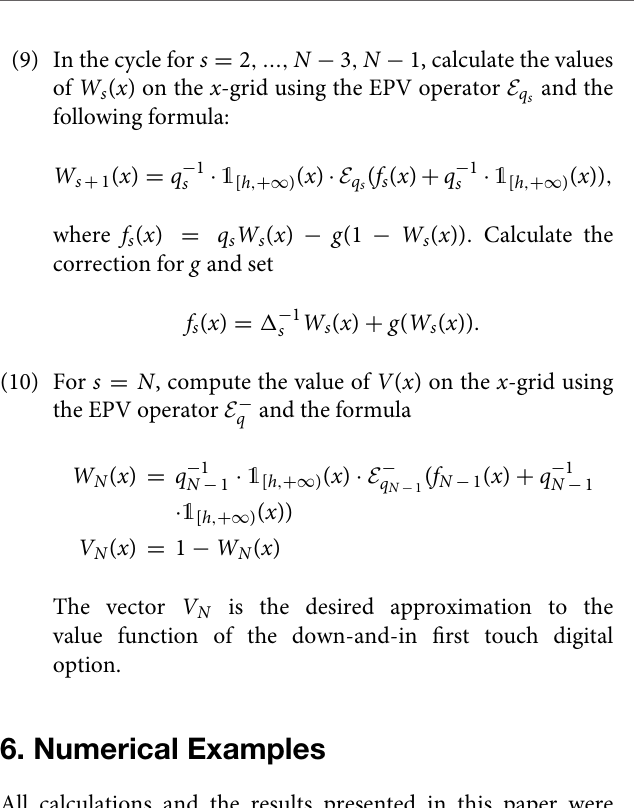
TABLE 1 | Prices of at-the-money European put for different models as of 9 January 2015, time to maturity T = 0 . 463 , spot, strike S = K = 24 , 000 , risk-free rate r = 0 . 52 % , collateral rate r C = 1 % , funding rate r F = 1 . 7 % default intensity λ = 0 . 05 , recovery rate R B = 0 . 4 , collateral threshold H B = 500 . Model BM DEJD